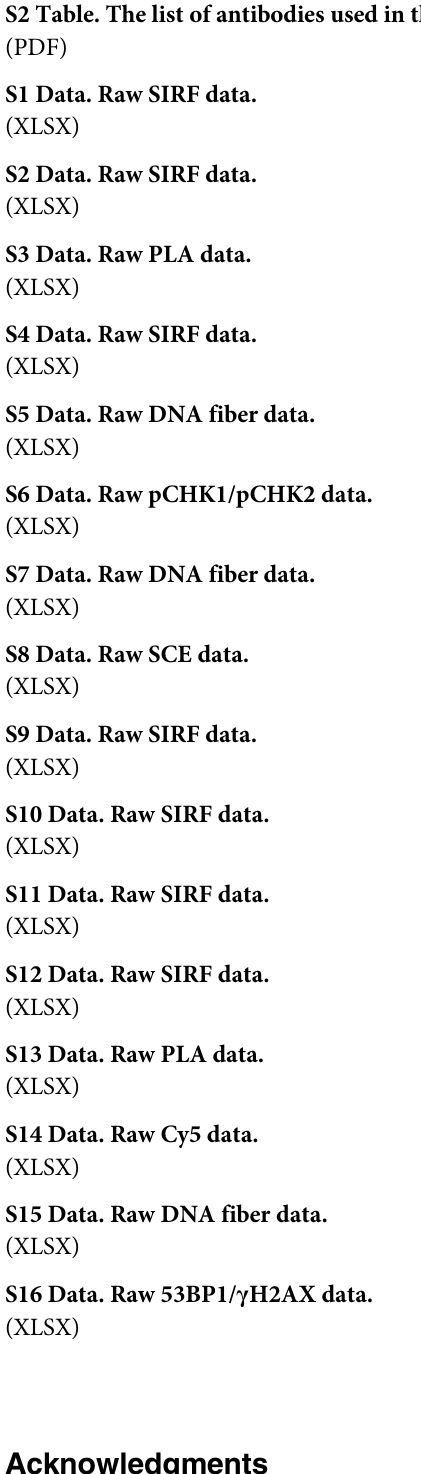
S2 Table. The list of antibodies used in this study.